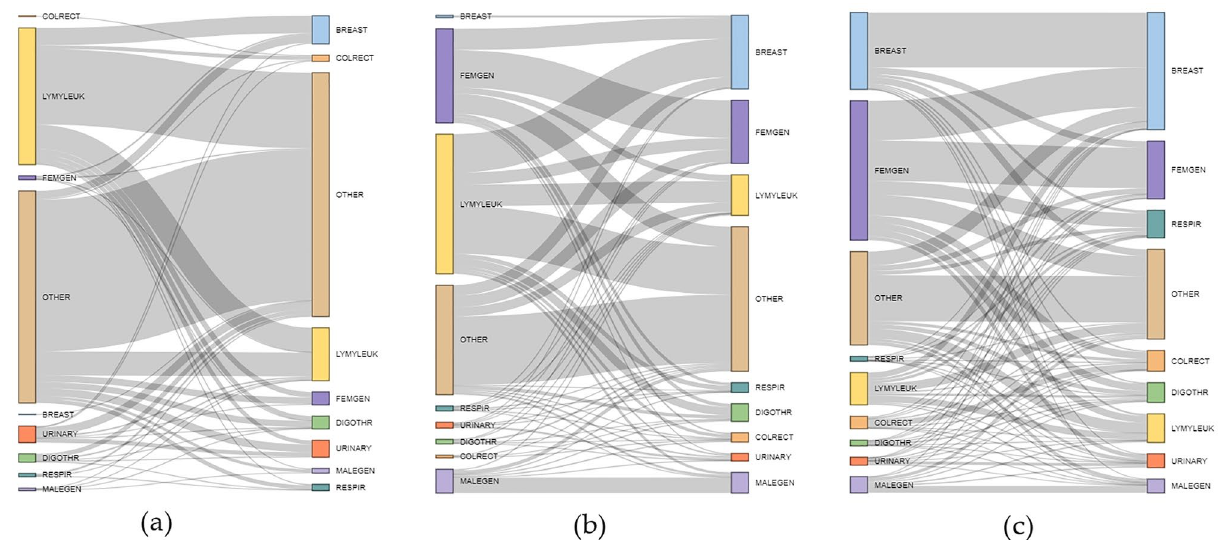
Figure 1. ( a ) Pediatric first (left) to second (right) tumor site within 30 years of first diagnosis (n = 930); ( b ) Adolescent first (left) to second (right) tumor site within 30 years of first diagnosis (n = 876); ( c ) Young adult first (left) to second (right) tumor site within 30 years of first diagnosis (n = 30,595).